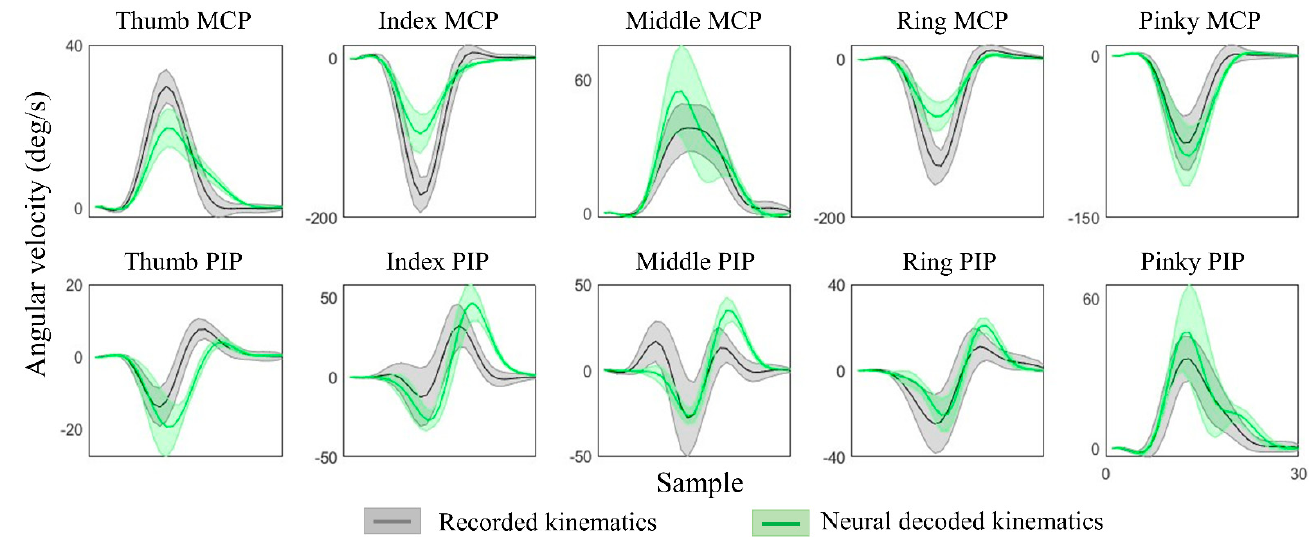
Figure 6. Recorded and neural decoded joint angular velocities of PIP and MCP joints of thumb and four fingers. The recorded kinematics (in grey) and neural decoded kinematics (in green) are averaged across all repetitions for Subject 2, Task 4, and the shaded regions represent standard deviations.